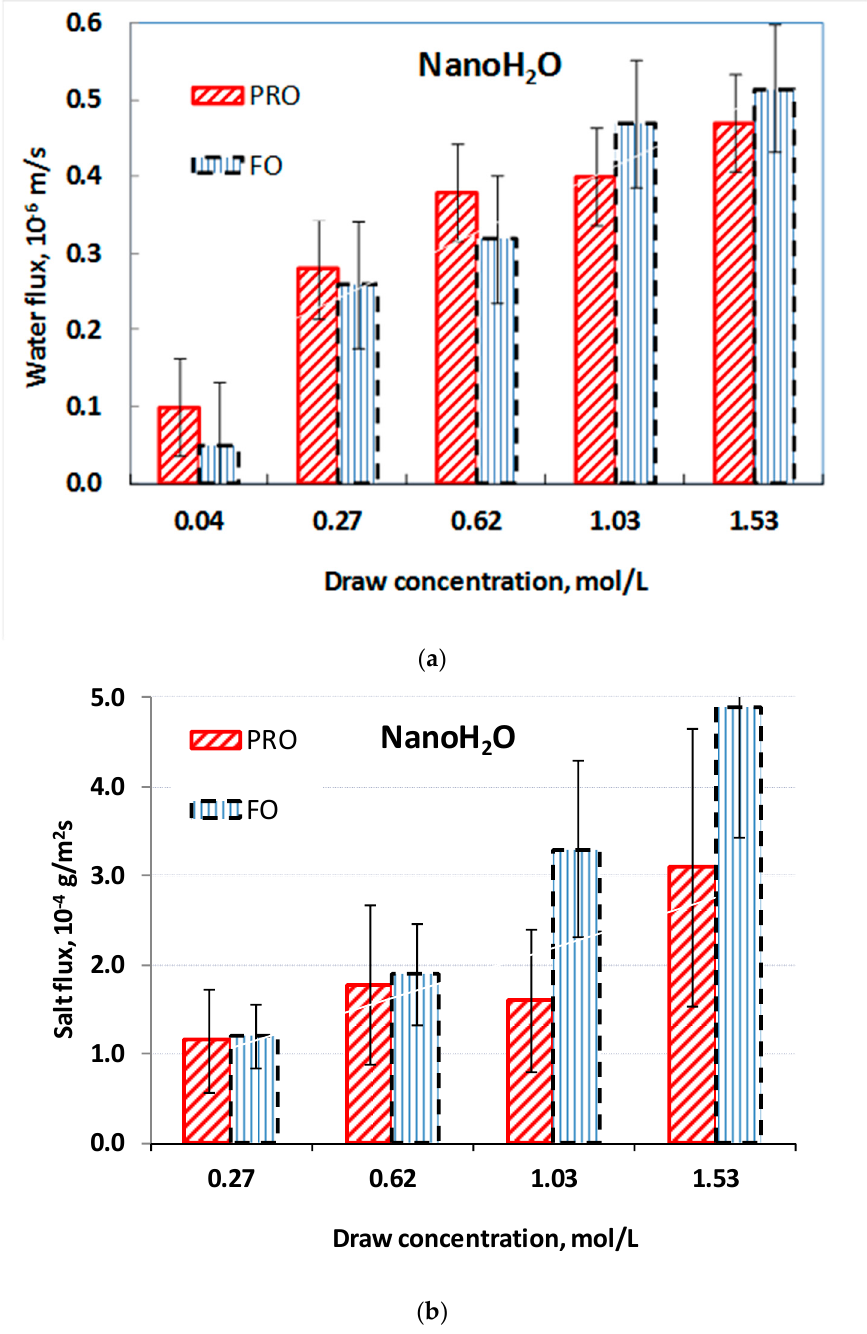
Figure 2. ( a ) Osmotic water fluxes of the NanoH 2 O membrane in pressure-retarded osmosis (PRO) and forward osmosis (FO) modes. Experiments were performed at 22 ◦ C and 0.20–0.25 m/s cross-flow velocity with DI water at the feed side and without a hydraulic pressure difference (1 × 10 − 6 m/s = 3.6 Lmh). ( b ) Salt fluxes of the NanoH 2 O membrane in PRO and FO modes. Experi- ments were performed at 22 ◦ C and 0.20–0.25 m/s cross-flow velocity with DI water at the feed side and without a hydraulic pressure